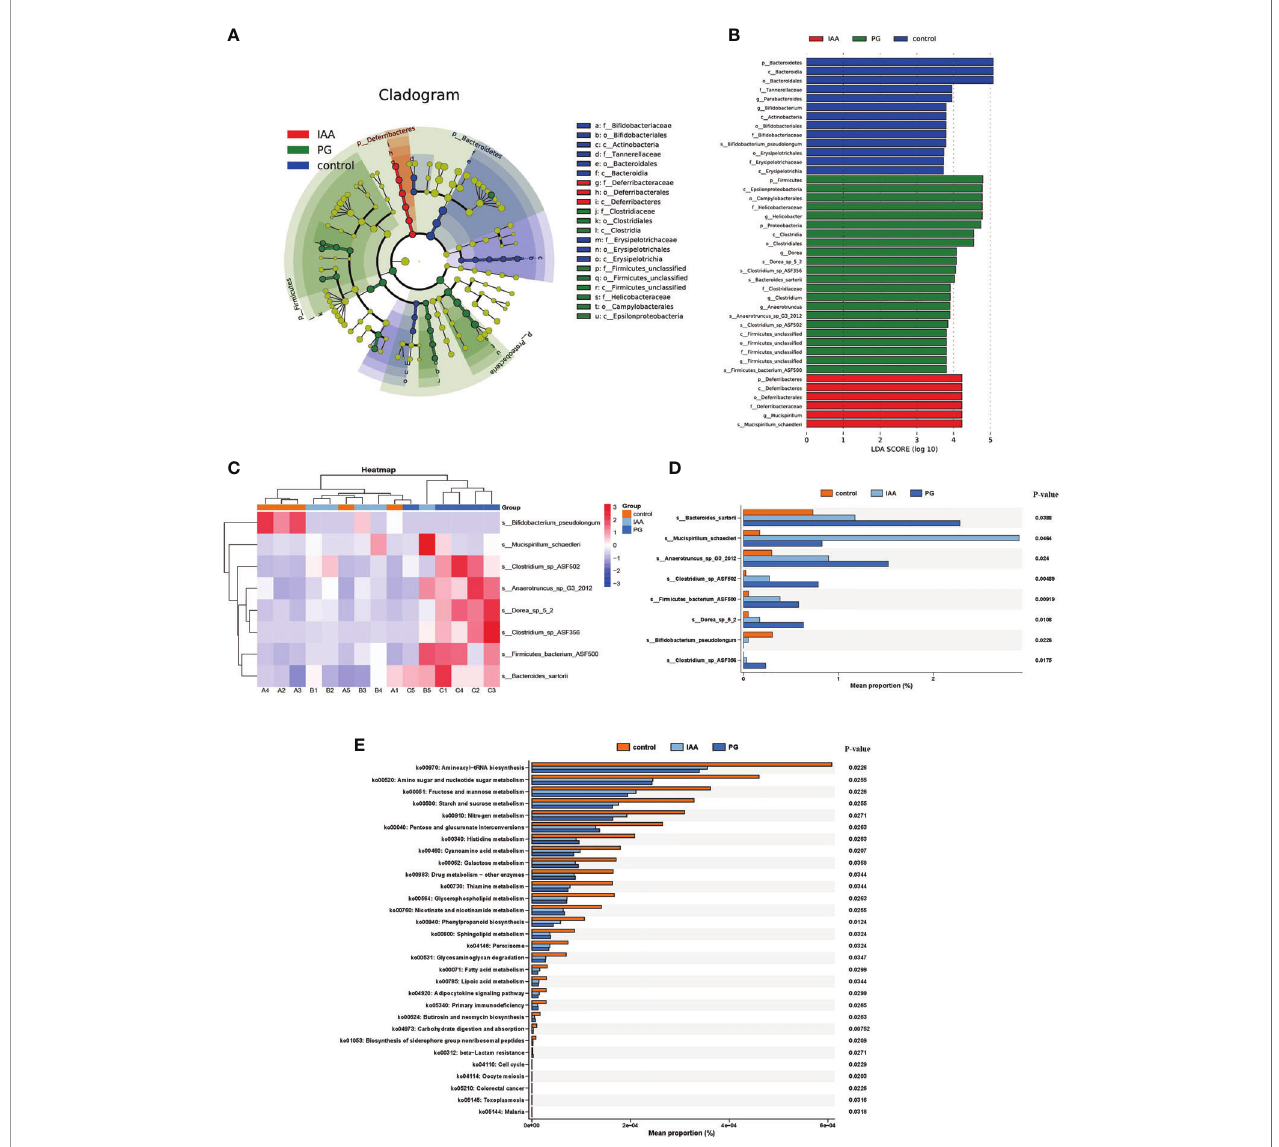
FIGURE 6 | Comparison of the taxa and functional pro fi les of intestinal microbiota in three groups. The linear discriminant analysis effect size (LEfSe) analysis of the intestinal microbiota at the species level in three groups was presented on the cladogram (A) and bar plot (B) with linear discriminant analysis (LDA) score ≥ 3 and p < 0.05. (C) Heat map of 8 signi fi cantly different taxon abundances at the species level in three groups. (D) Box plot generated by rank-sum test (Kruskal – Wallis test) of relative abundance among the intestinal microbiota at the species level in three groups. (E) The differential analysis of functional predictions in three groups was performed based on level 3 of the Kyoto Encyclopedia of Genes and Genomes (KEGG) functional